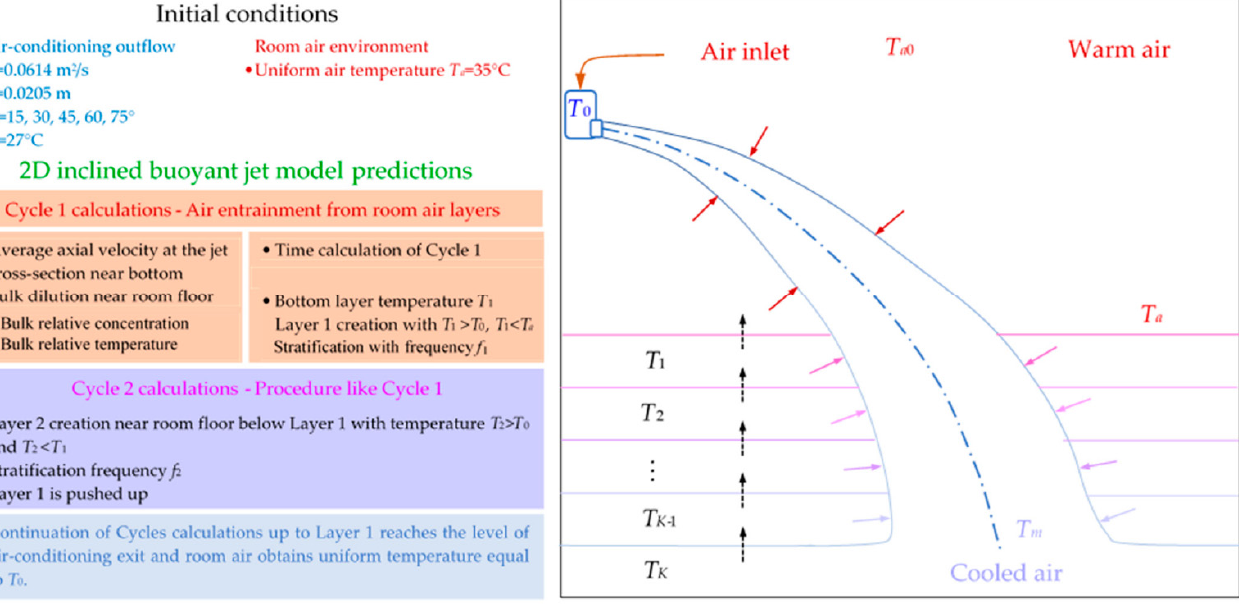
Figure 3. Configuration sketch of the bottom-up approach used to solve the quasi-steady phenom- enon of a room air conditioning. The colours show the cooling transition from warm air (red) to cool air (blue).